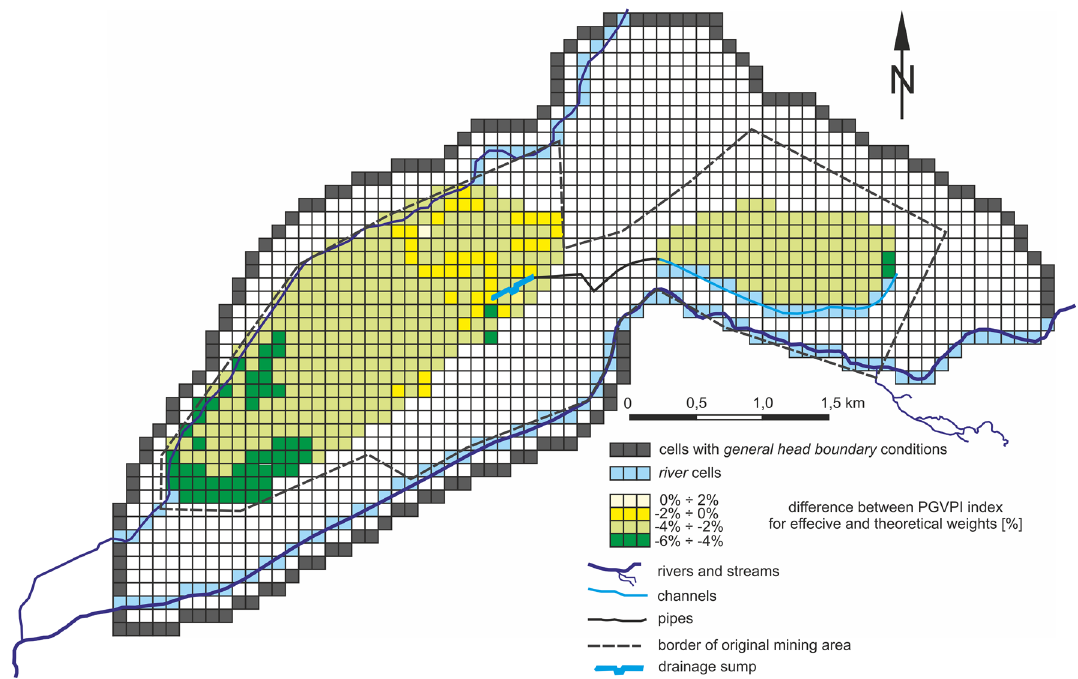
Fig. 9 percentage difference between the PGVPI calculated for theoretical and effective weights Table 4 A list of selected statistical values for the parameters of the proposed method for assessing groundwater vulnerability to groundwater pollution in areas of reclaimed open pit